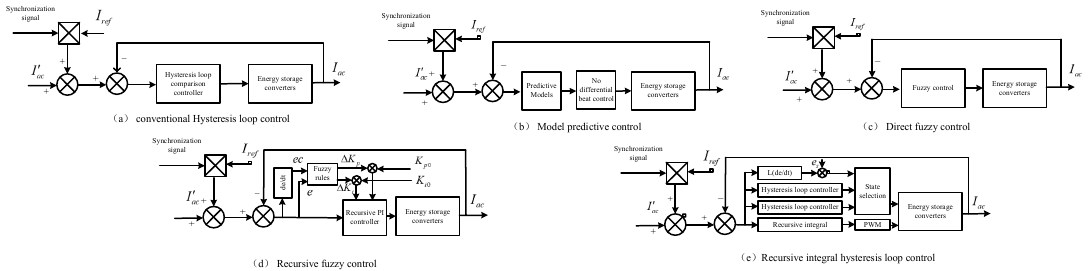
Figure 33. Block diagram of AC inner loop control.